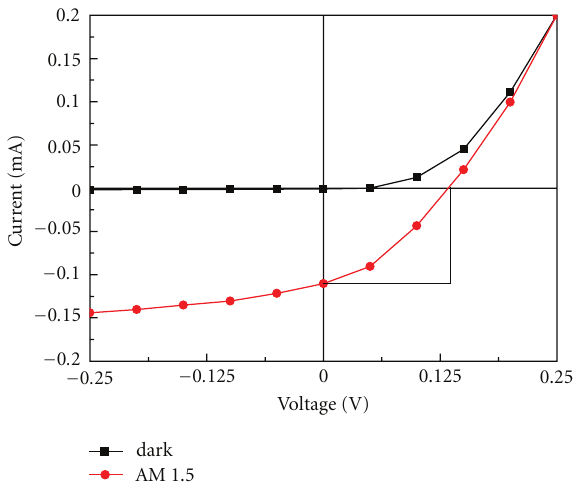
Figure 6: I - V curves evaluated for IZO/Cu 2 O heterostructure solar cells in the dark and under an